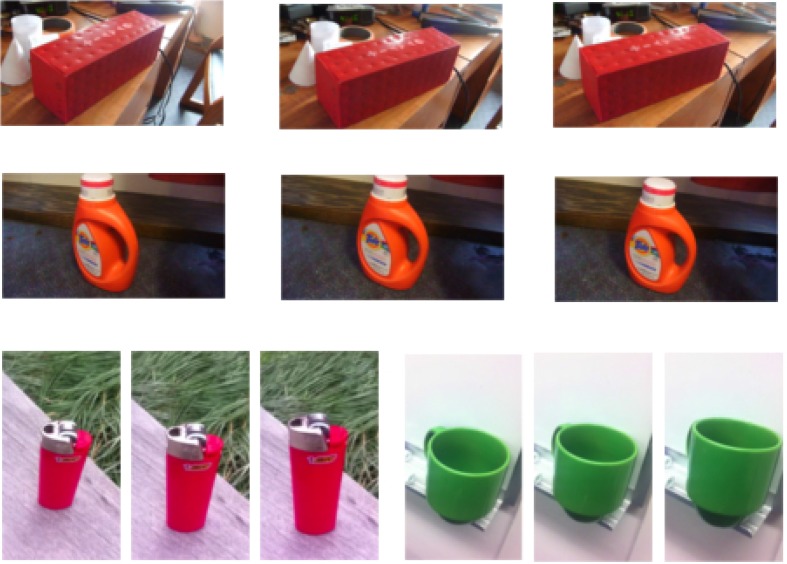
Representative frames sampled from a collected video database of everyday objects undergoing 3D transformations (i.e., combination of translation, scaling, and in-depth rotation).